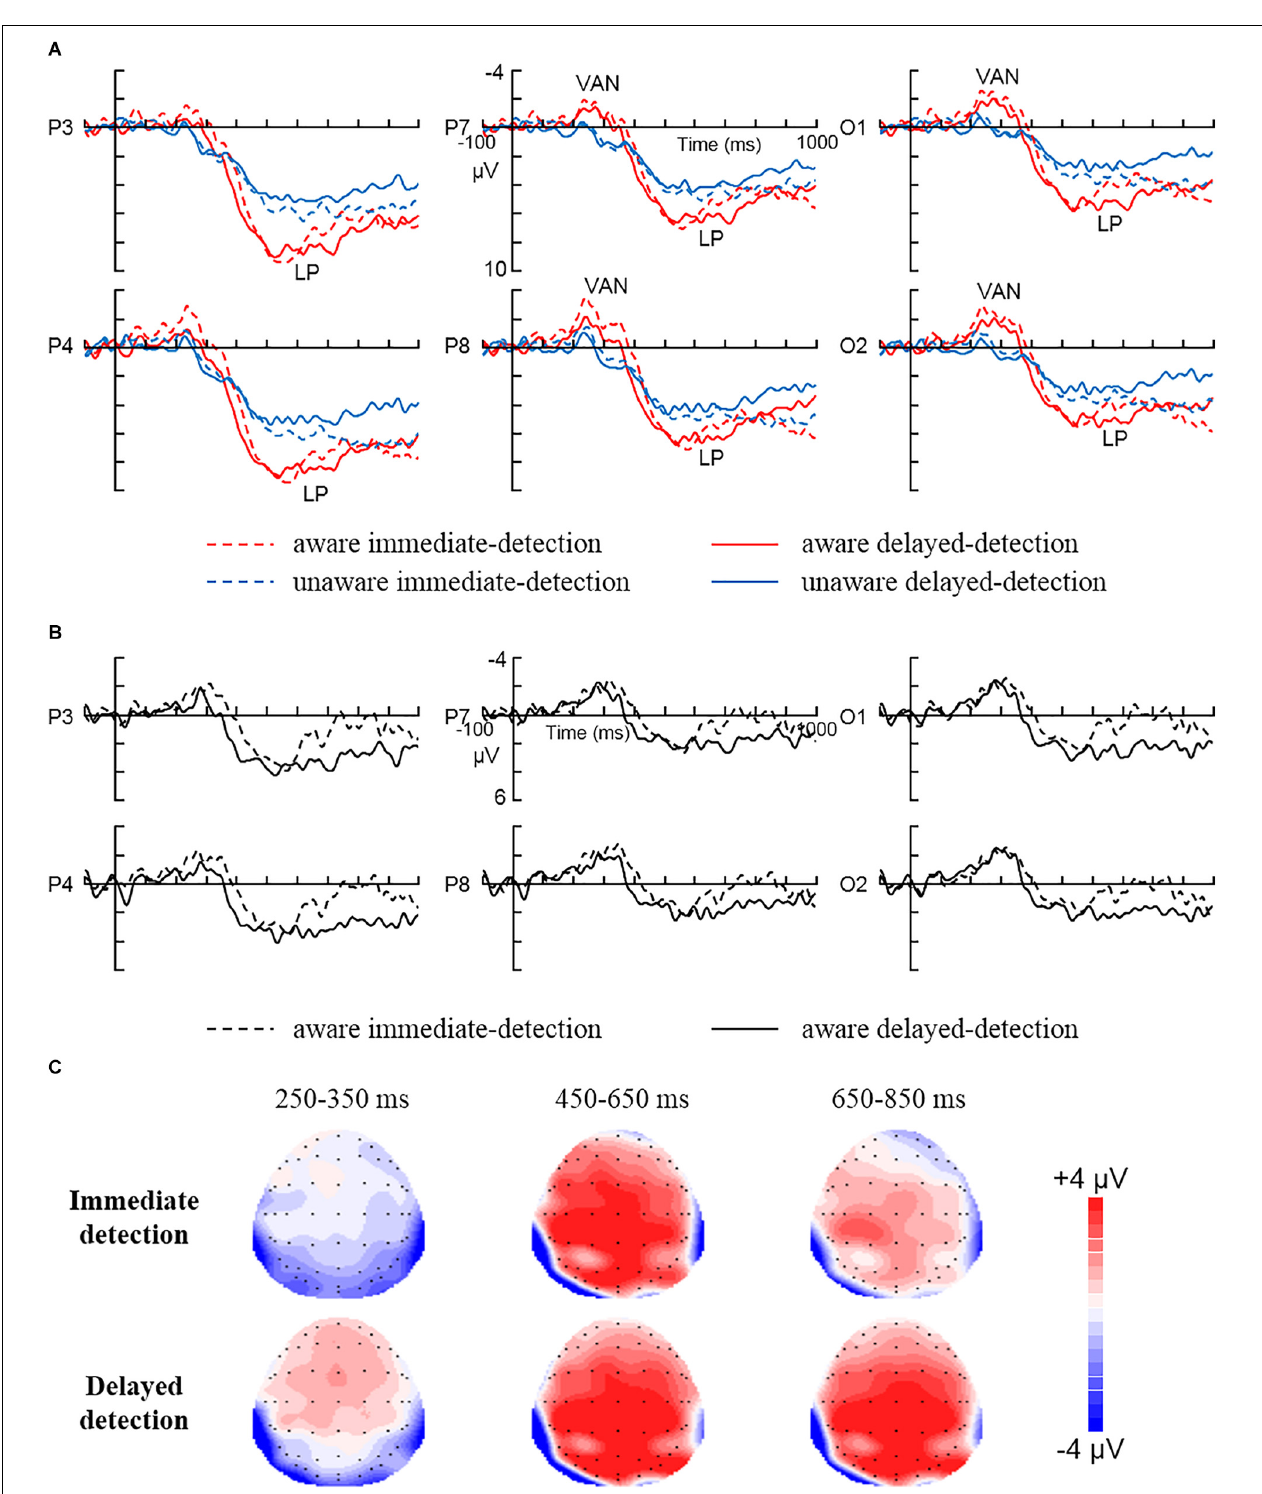
FIGURE 2 | The grand average ERPs for each condition. (A) The grand average ERPs to aware immediate-detection, aware delayed-detection, unaware immediate-detection, and unaware delayed-detection in parietal electrodes (P3 and P4), posterior temporal electrodes (P7 and P8), and occipital electrodes (O1 and O2). (B) The difference waves (aware minus unaware trials) related to immediate detection and delayed detection over parietal electrodes (P3 and P4), posterior temporal electrodes (P7 and P8), and occipital electrodes (O1 and O2). (C) The scalp topography of the mean amplitude difference between aware and unaware during 250–350, 450–650, and 650–850 ms in the immediate detection and delayed detection